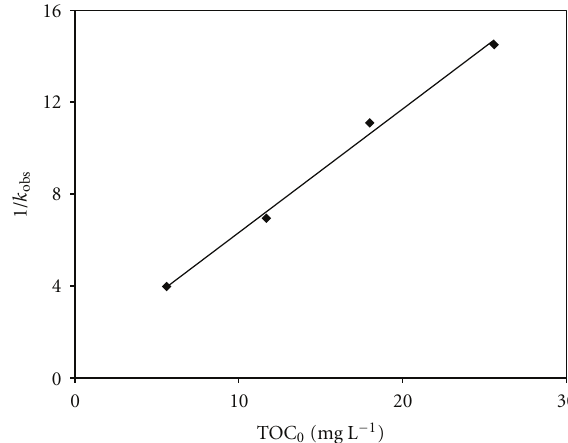
Figure 12: E ff ect of initial AMOX concentration in the photocat- alytic reaction. Figure 13: Determination of the adsorption equilibrium con- stant, k AMOX , and the second order rate constant, k c , for the Langmuir-Hinshelwood kinetic